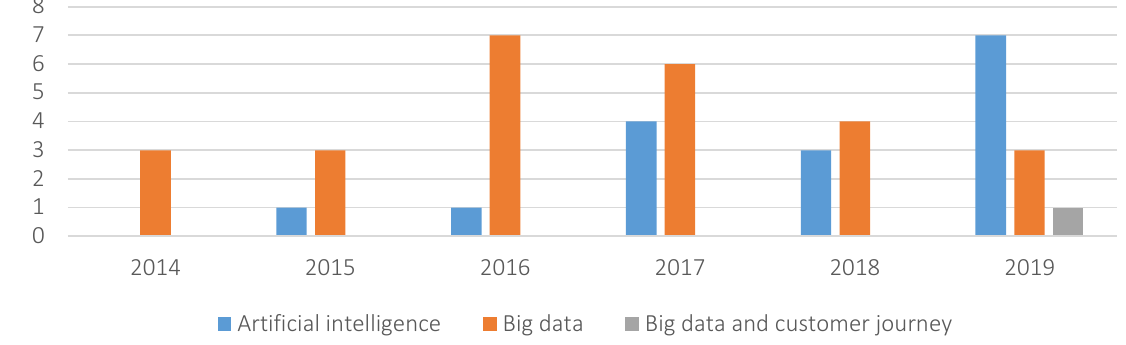
Figure 1. Distribution of publications by